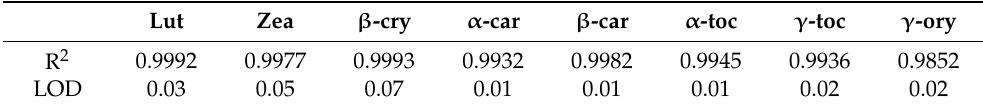
Table 6. R 2 and limit of detection values of the validated HPLC method for bioactive compounds: carotenoids, tocopherols, and γ -oryzanol in wheat germ extracts. Lut Zea β -cry α -car β -car α -toc γ -toc γ -ory R 2 0.9992 0.9977 0.9993 0.9932 0.9982 0.9945 0.9936 0.9852 LOD 0.03 0.05 0.07 0.01 0.01 0.01 0.02 0.02